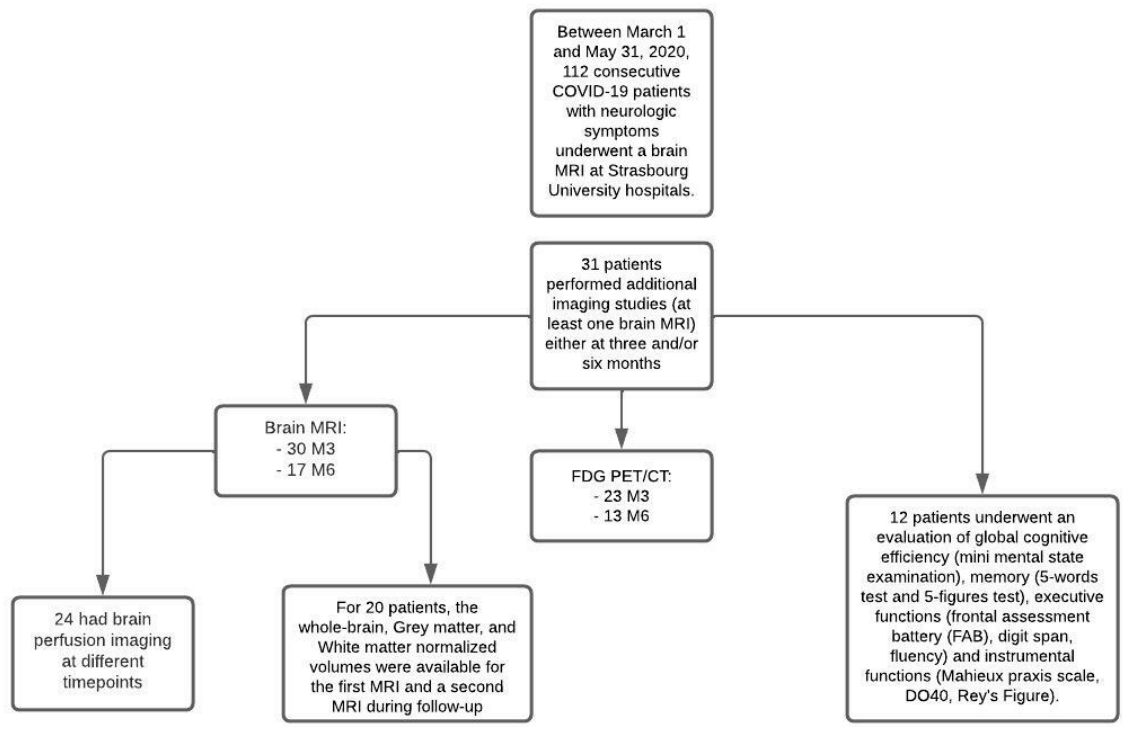
Figure 1. Flow diagram.